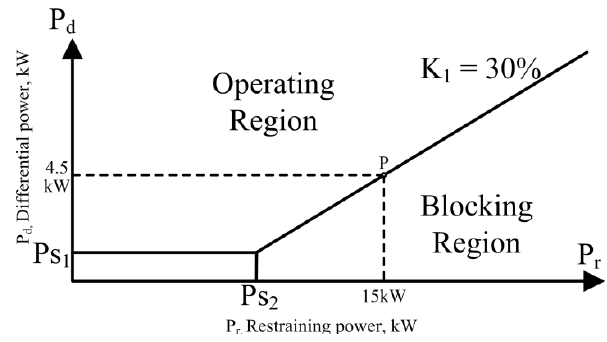
Fig. 3. Differential power V s restraining power characteristic.